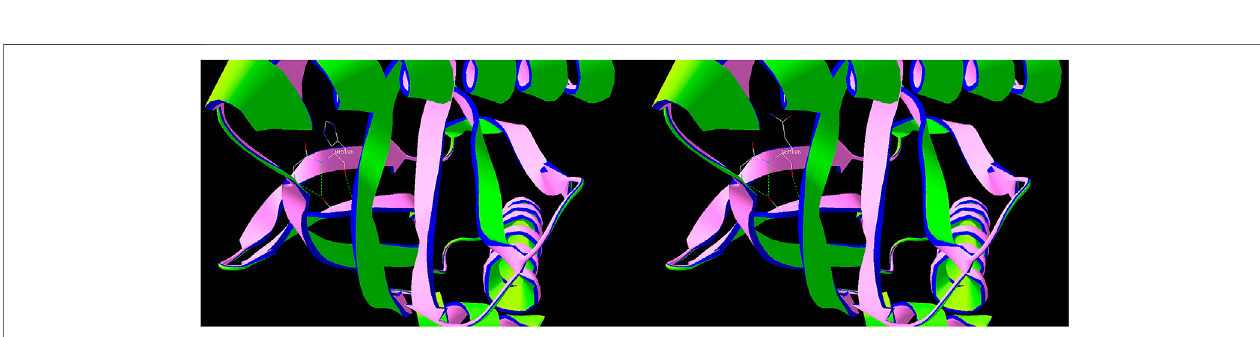
FIGURE 6 | Predicted protein structure of DAB1 using the SWISS-MODEL server. Green indicates hydrogen bonds, used to connect amino acids.